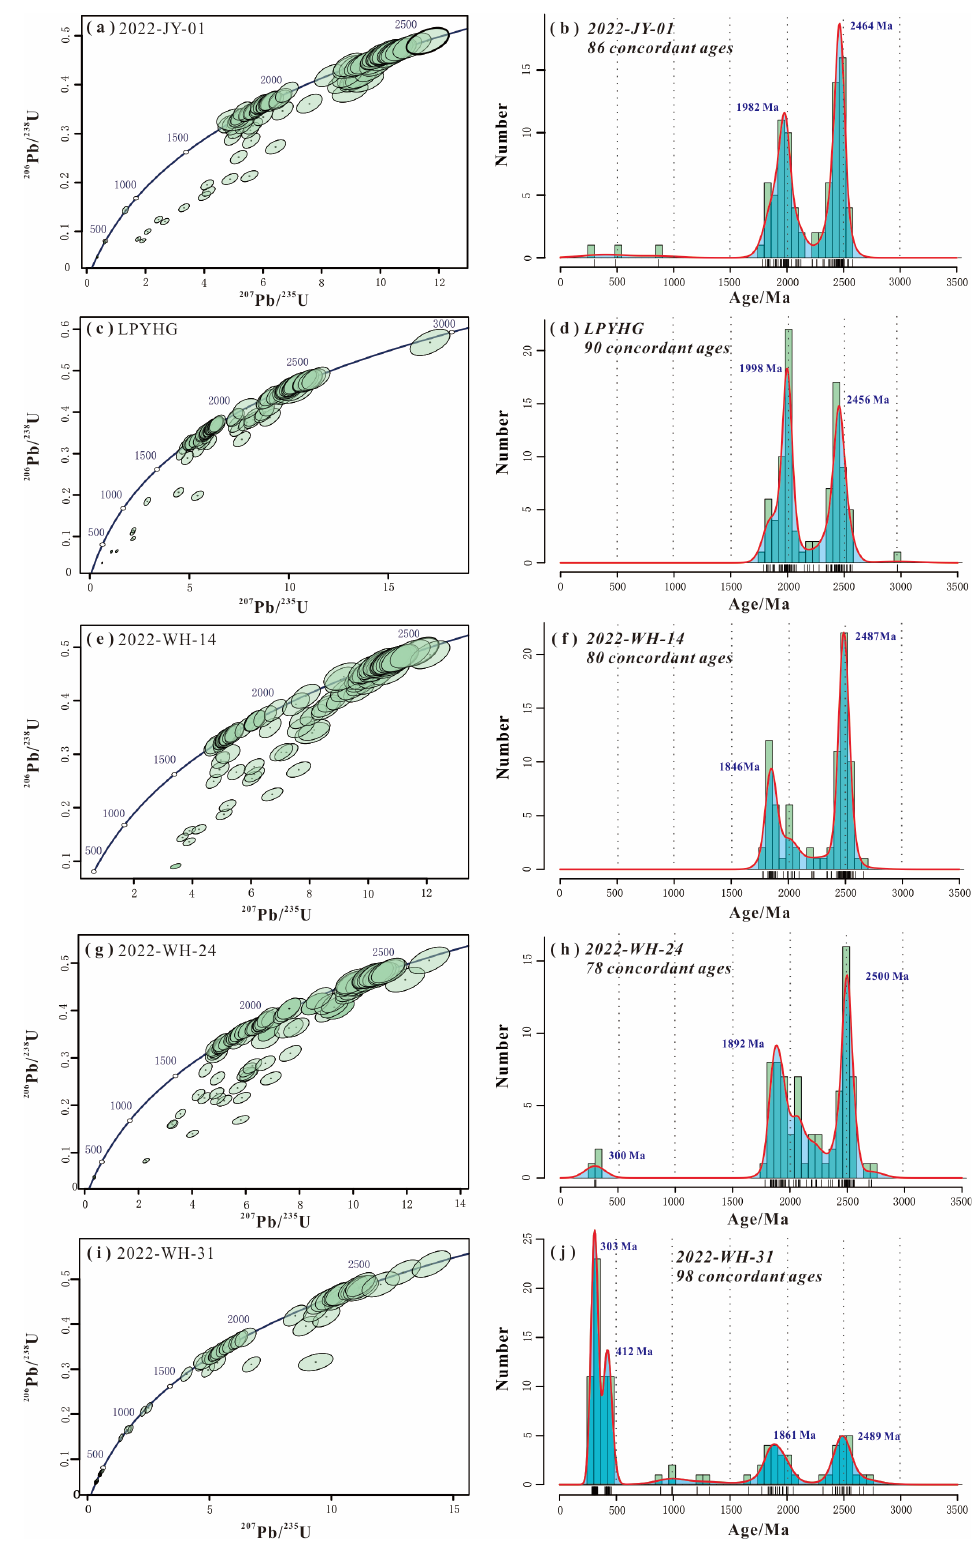
Figure 9. Concordia diagrams ( a , c , e , g , i ) showing the results of single ‐ grain zircon U ‐ Pb analyses and frequency (bars) and relative probability density distribution (curves) of ages ( b , d , f , h , j ) for sandstone samples from Carboniferous and Permian strata. Ellipses show individual analyses. Error ellipses represent 2 σ uncertainties.